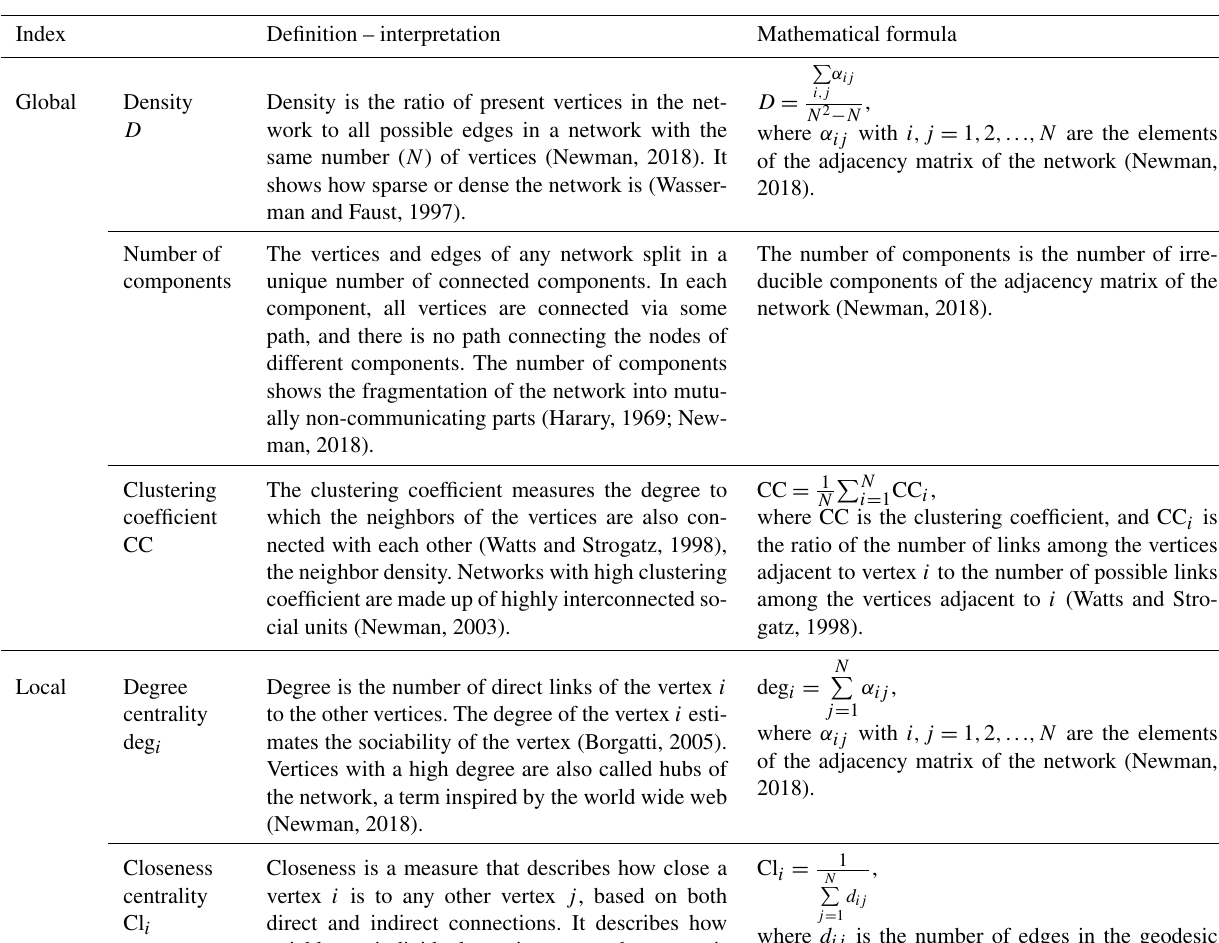
Table 1. Definition, interpretation, and mathematical formulae of the network